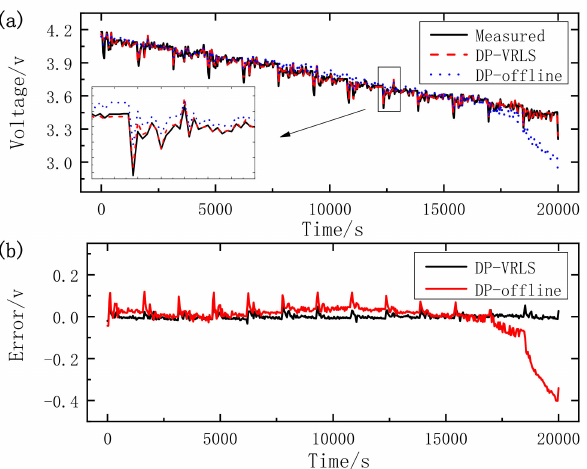
Figure 6. The estimated terminal voltage and corresponding errors based on different battery parameter identification under UDDS condition: ( a ) voltage comparison; ( b ) error of voltage.